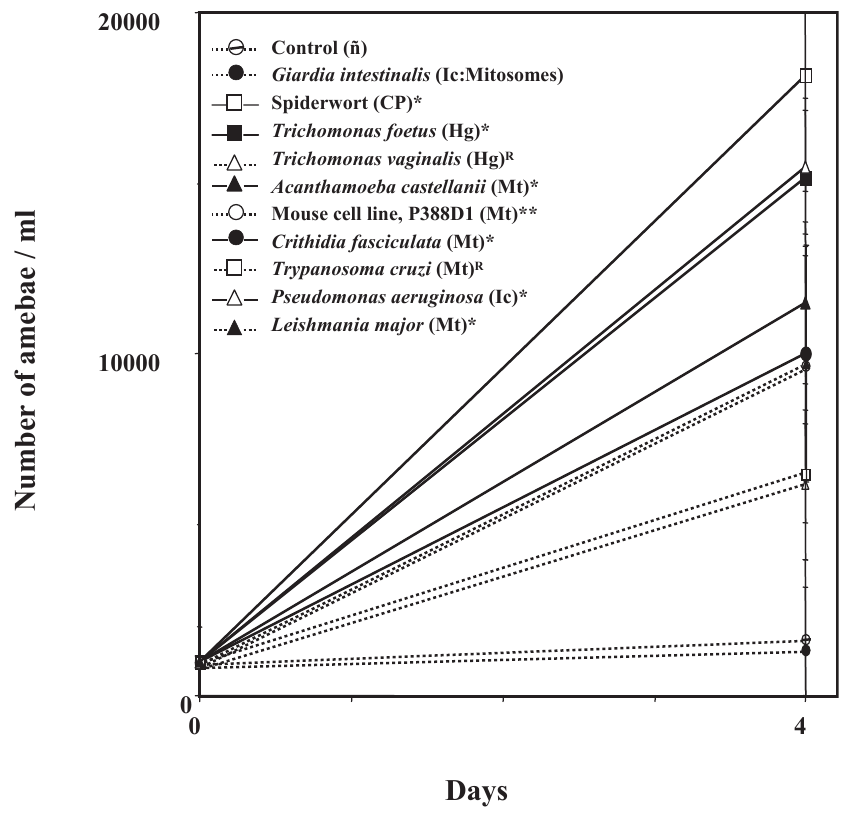
Fig. 1. – The effect of intact cells (Ic) and the fractions of mitochondria (Mt), chloroplasts (Cp) and hydrogenosomes (Hg) from ten types of cells, including bacterial, mammalian, plant and pro- tozoan cells, on the growth of Enta- moeba dispar . The cellular components were steri- lized by autoclaving at 121° C for 15 minutes. The growth kinetics of the E. dispar AS 16 IR strain in the YIGADHA-S medium are shown (mean numbers of amoebae in duplicate cul- tures are plotted). *, **: the mean of the growth-kinetic level was significantly higher than that of the control (* p < 0.01 and ** p < 0.05 by Dunnett’s test). R: the significant difference was retained by Dunnett’s test ( p <